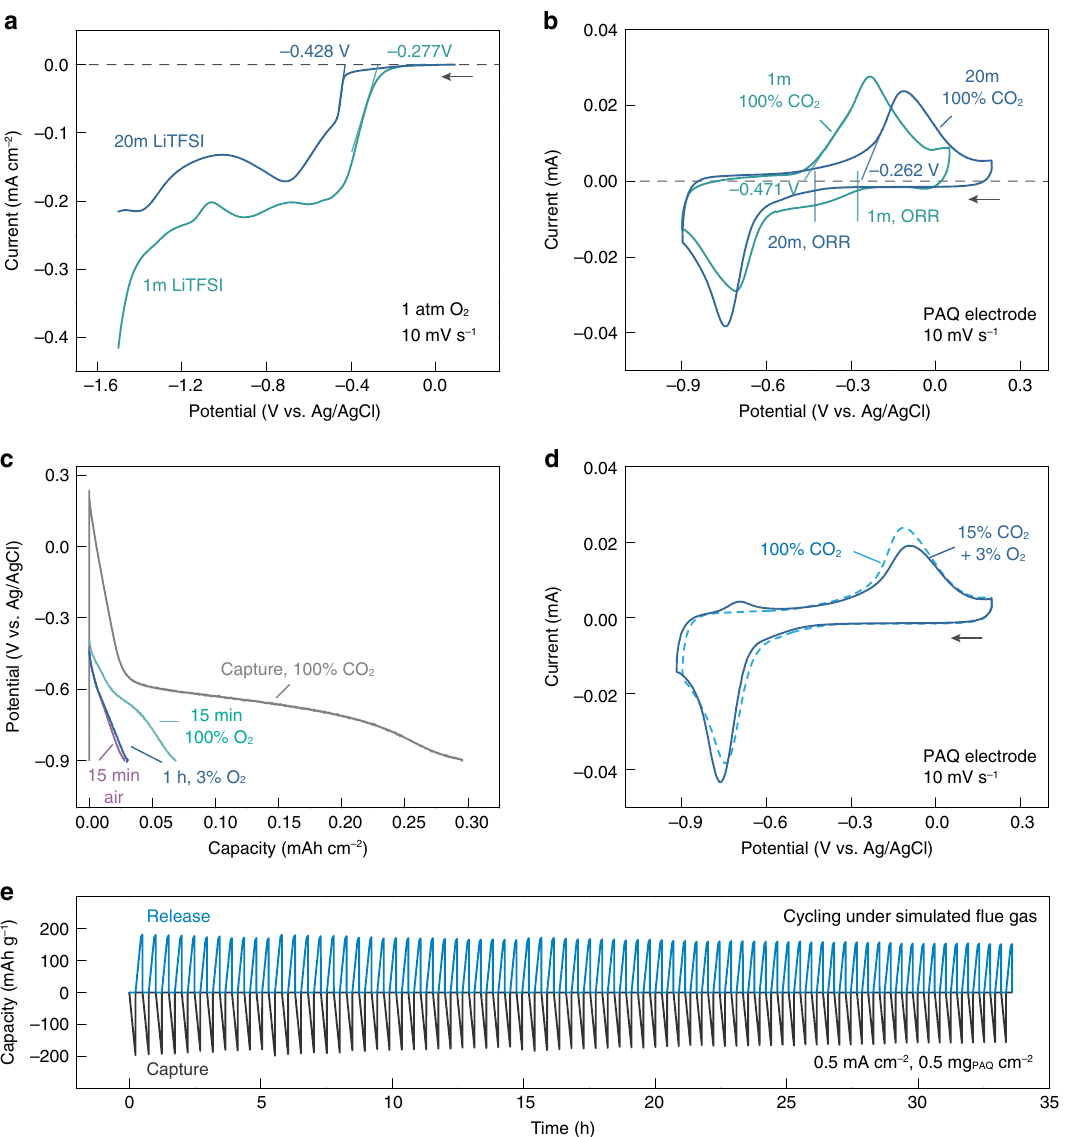
Fig. 7 Electrochemical CO 2 capture-release in the presence of O 2 . a Linear sweep voltammograms of 1 and 20m LiTFSI saturated with O 2 measured with a glassy carbon electrode at a rate of 10 mV s − 1 . b Comparison between the oxidation potential of PAQ-CO 2 (with onset potential noted) and the ORR potential (from a ) in 1 and 20m LiTFSI. c Reduction pro fi les of PAQ under CO 2 in 20m LiTFSI and of the same electrode after being rested in 100% O 2 (15 min), air (15 min) and 3% O 2 (1 h), respectively. The reductions were carried out at a current density of 0.5 mA cm − 2 and the PAQ was immobilized on carbon felt at a mass loading of 1.2 mg cm − 2 . d CV scans of PAQ under pure CO 2 and simulated fl ue gas in 20m LiTFSI. The ratio between the total anodic and cathodic capacities was 87.3% and 80.7% for pure CO 2 and simulated fl ue gas, respectively. The additional anodic peak observed under simulated fl ue gas corresponds to the oxidation of quinone anions that did not react with CO 2 due to mass transport limitation. For ( b ) and ( d ), the CV scans were conducted at a rate of 10 mV s − 1 with 1.5 μ g PAQ loaded on the glassy carbon electrode. e The capture-release capacity of PAQ during continuous cycling under simulated fl ue gas. The cycling was carried out in the membrane fl ow cell con fi guration at a current density of 0.5 mA cm − 2 and a PAQ mass loading of 0.5 mg cm − 2 (immobilized on carbon felt). CC capture and CC/CV release protocol was adopted with the cut-off voltage being − 1.35 and − 0.1 V, respectively. Each capture/release step has a time scale of ~15 min. Source data are provided as a Source Data fi